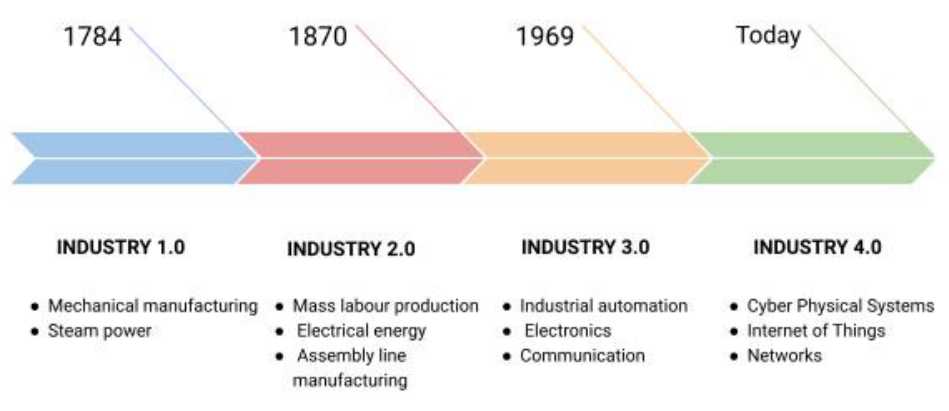
Figure 1. Industrial